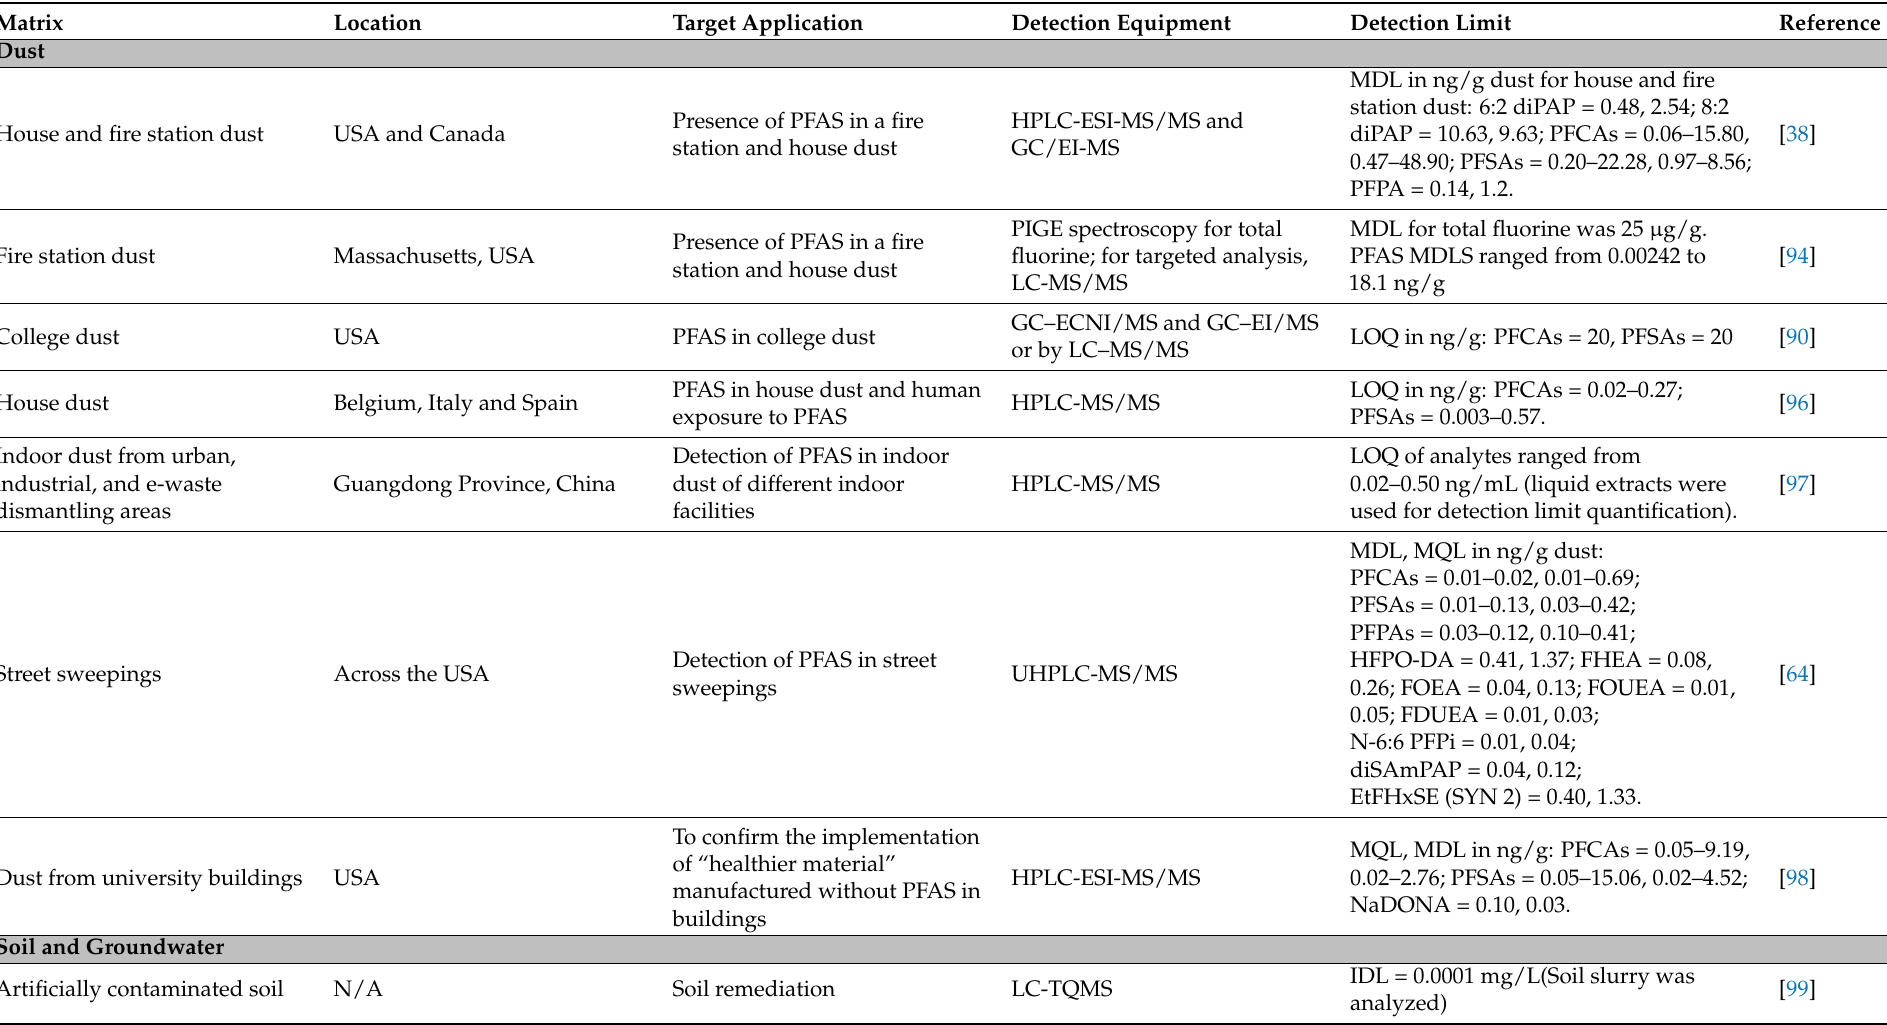
Table 3. Analytical methods used in the detection of PFAS (precursors of PFCAs, PFSAs, sulfonamide, and telomers) in various